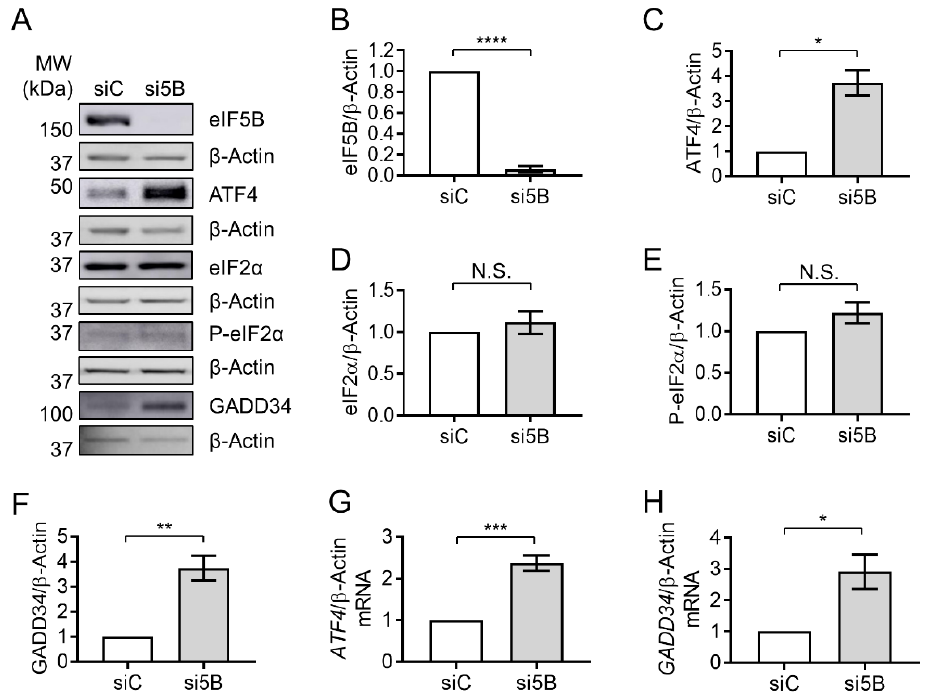
Figure 1. Depletion of eIF5B leads to increased levels of the ATF4 protein. HEK293T cells were reverse-transfected with a non-specific control siRNA (siC) or an eIF5B-specific siRNA pool (si5B), incubated 96 h, harvested in RIPA lysis buffer, and 20 µ g of total protein resolved by SDS-PAGE before performing immunoblotting. ( A ) Representative images of immunoblots probing for eIF5B, ATF4, eIF2 α , P-eIF2 α , GADD34, or β -Actin (internal control). ( B – H ) Quantitation of eIF5B ( B ), ATF4 ( C ), eIF2 α ( D ), P-eIF2 α ( E ), or GADD34 ( F ), normalized to β -Actin, from HEK293T cells. ( G , H ) Total RNA was isolated from control or eIF5B-depleted HEK263T cells and subjected to RT-qPCR analysis of steady-state mRNA levels for ATF4 ( G ) or GADD34 ( H ), normalized to β -Actin mRNA. Data are expressed as mean ± SEM for at least 3 ( B – F ) and up to 4 ( G , H ) independent biological replicates. * p < 0.05; ** p < 0.01; *** p < 0.001; **** p < 0.0001. N.S., not statistically